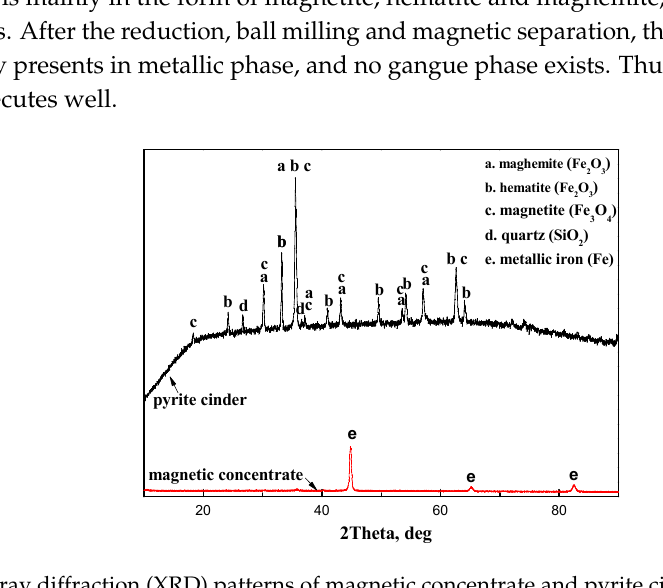
Figure 8. X ‐ ray diffraction (XRD) patterns of magnetic concentrate and pyrite cinder (borax dosage of 5%, reducing at 1050 °C for 80 min, and grinding fineness (<0.044 mm) exceeding 81%).